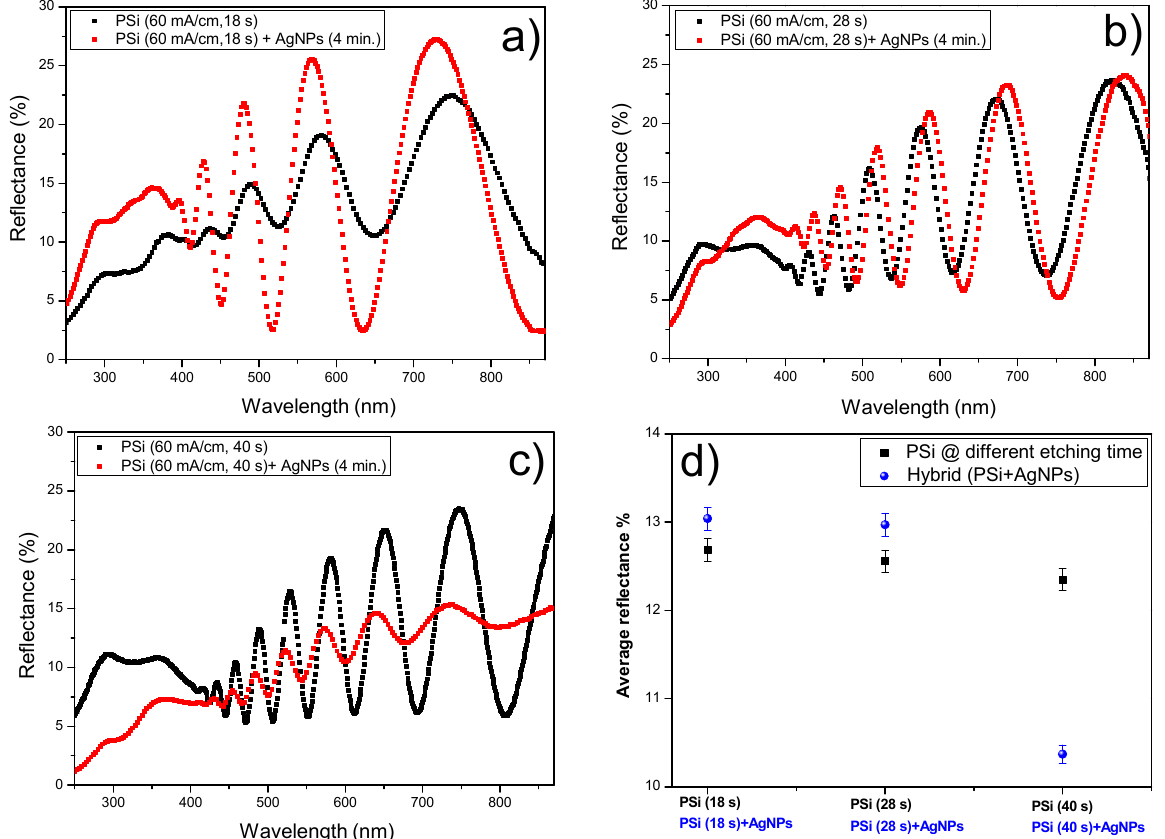
Figure 5. Overall reflectance property of PSi and hybrid PSi + AgNPs: ( a ) the thickness of PSi layer is 400 nm, ( b ) the thickness of PSi layer is 1000 nm, ( c ) the thickness of PSi layer is 1400 nm, and ( d ) comparison between the average reflectance of PSi and PSi + AgNPs at different thicknesses of PSi layers. AgNPs infiltrated at the same conditions.